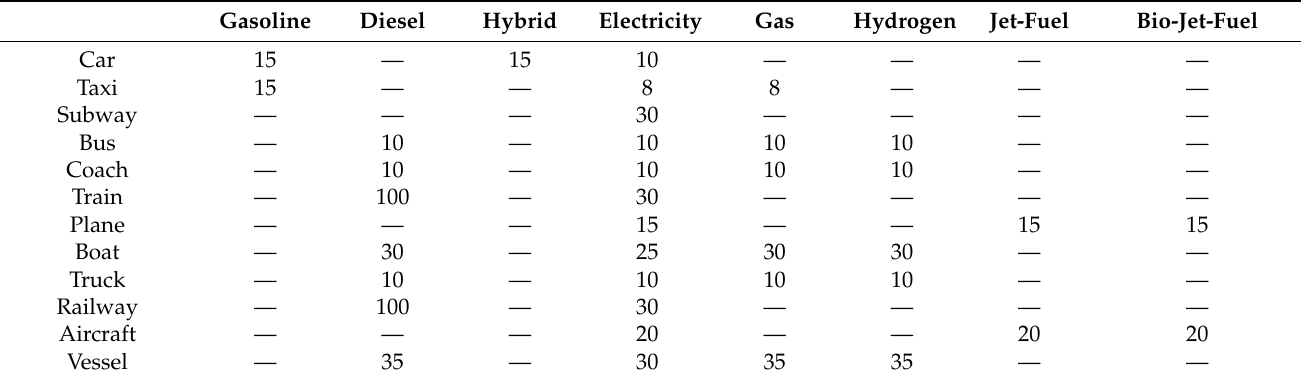
Table A1. Maximum service life of vehicles.